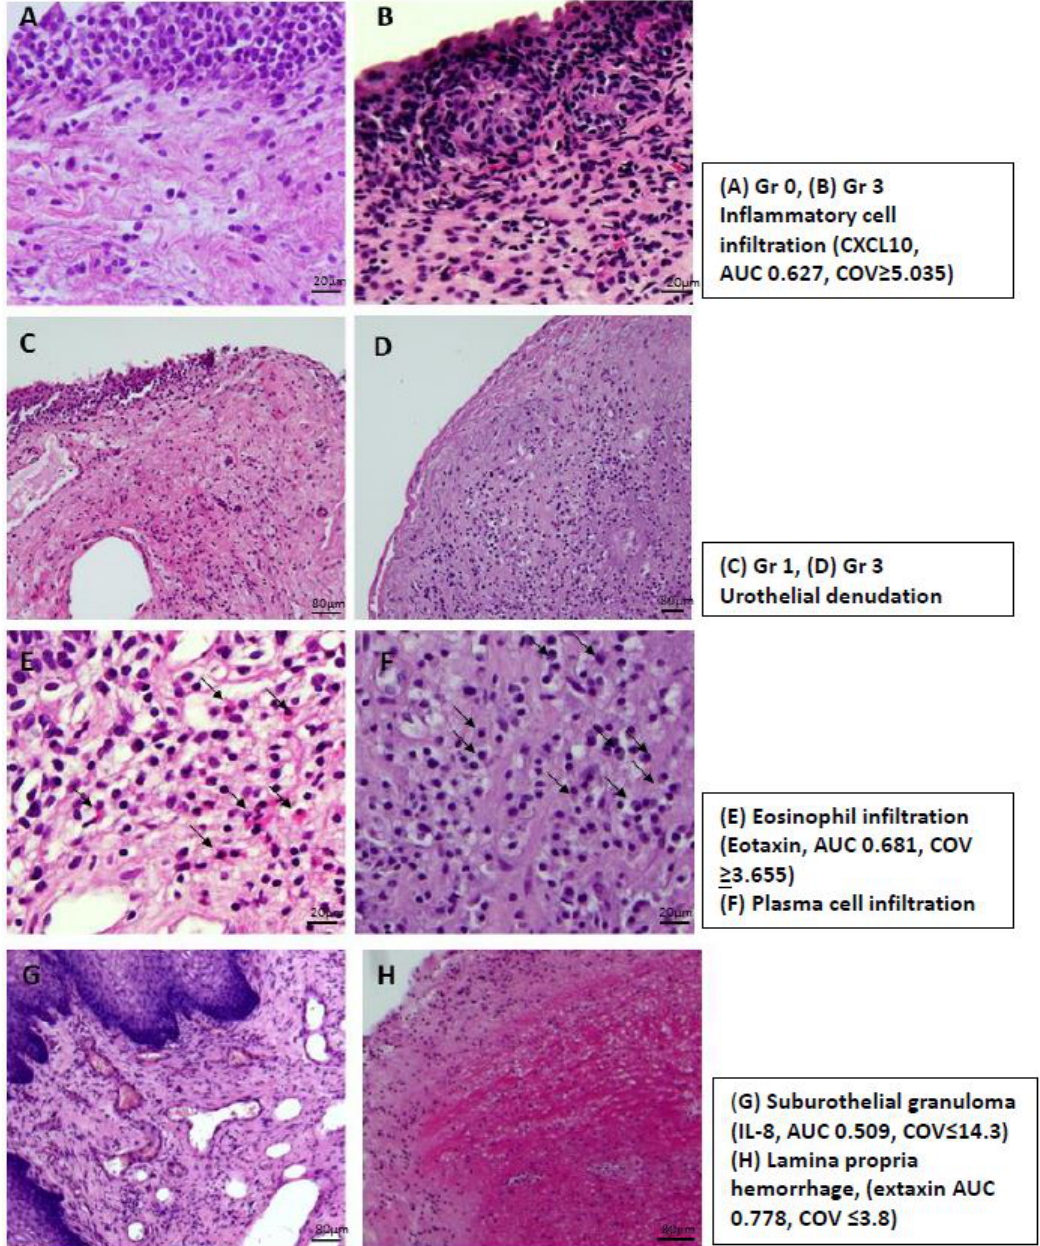
Figure 1. The histopathological findings of interstitial cystitis/bladder pain syndrome and the urine biomarker to differentiate the histopathological finding: ( A , B ) inflammatory cell infiltration, ( C , D ) urothelial denudation grade, ( E ) eosinophil infiltration, ( F ) plasma cell infiltration, ( G ) suburothelial granulation, and ( H ) lamina propria hemorrhage. Bar scale: ( A , B , E , F ) 20 μm, ( C , D , G , H ) 80 μm.